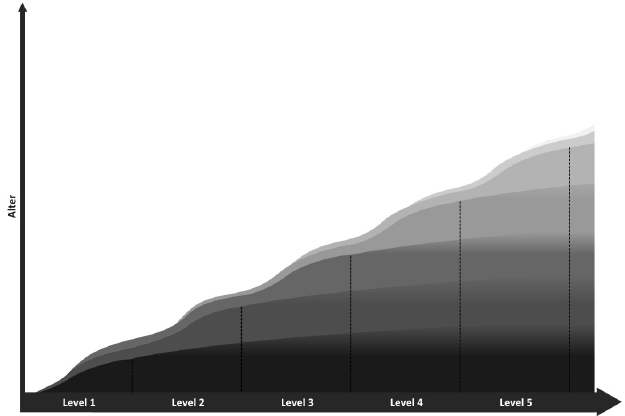
Figure 2: Levels of the MARKO-D